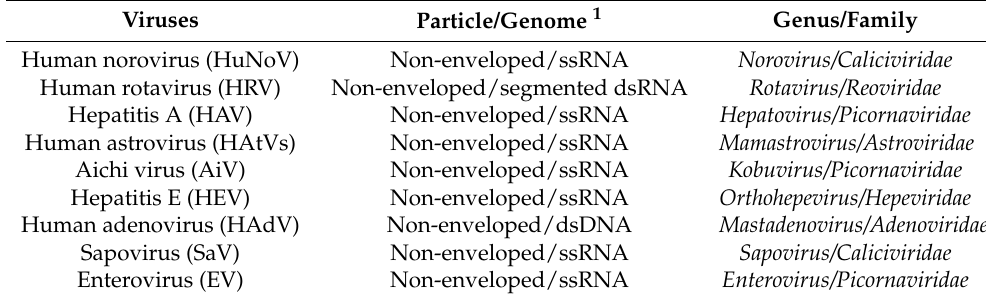
Table 1. Foodborne